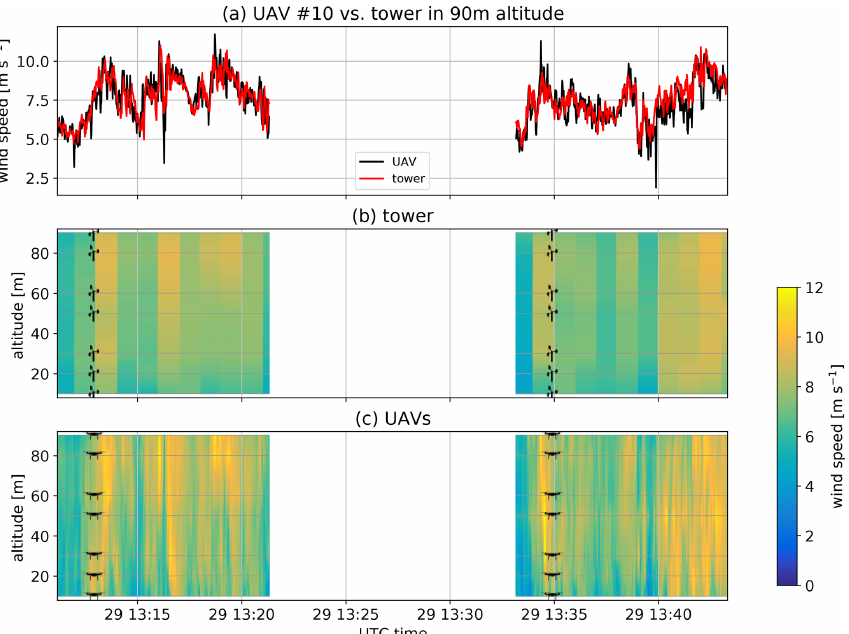
Figure 7. Comparison of drone tower to reference data from the tower for flight no. 61 and no. 62: (a) one single UAV at 90m altitude vs. sonic measurements, (b) time series of tower measurements at different altitudes, and (c) corresponding UAV time series of seven quadrotors at different altitudes.